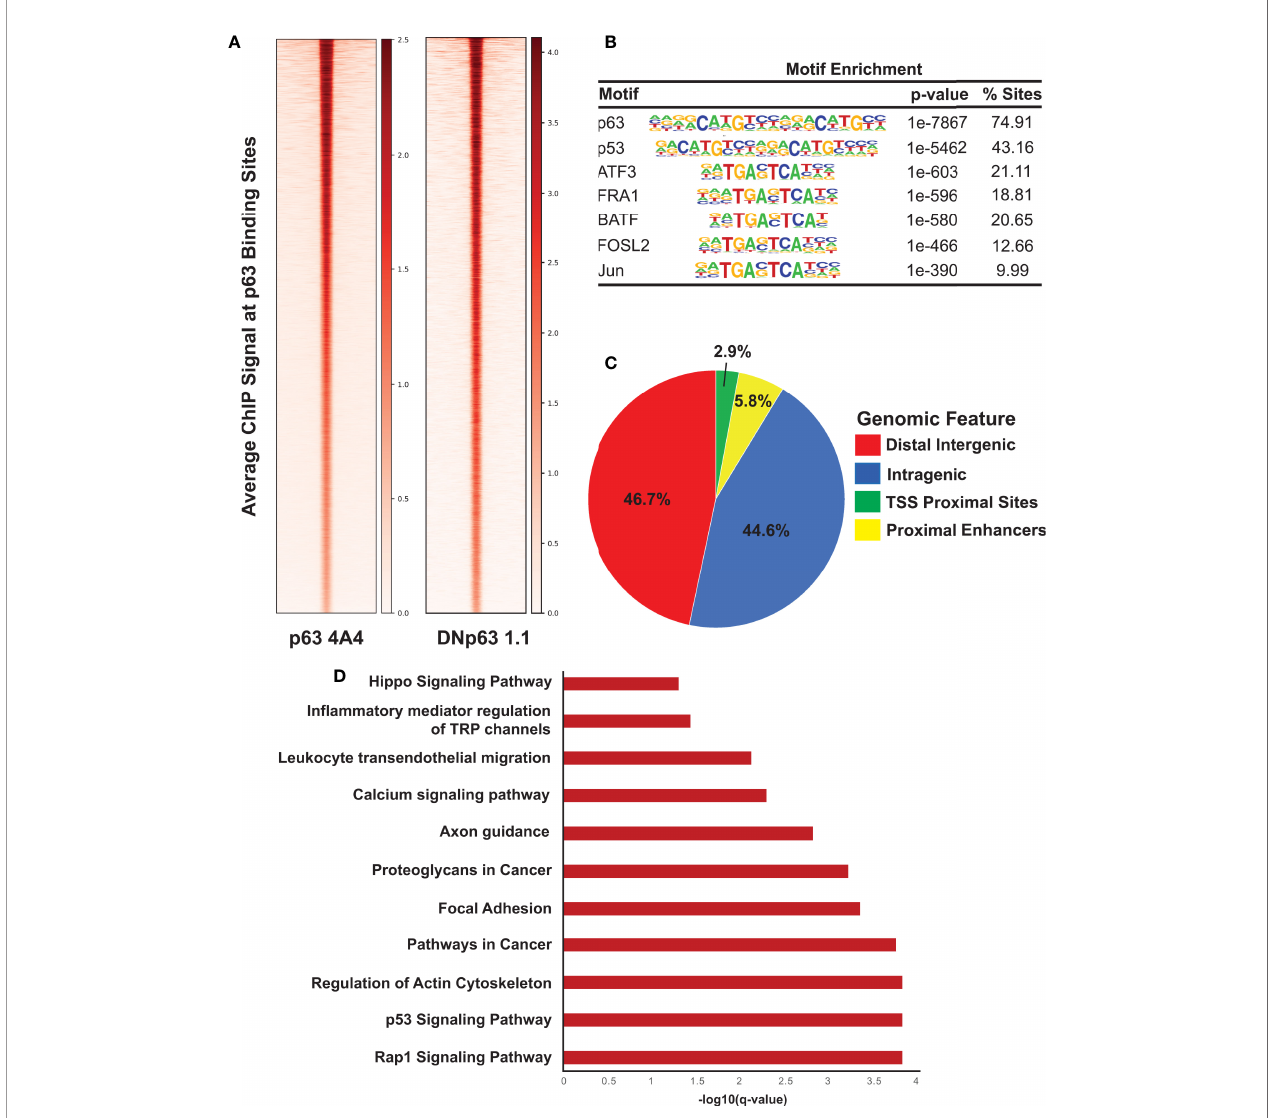
FIGURE 2 | ChIP-seq analysis reveals direct p63 targets in SCC104 cells. (A) Heatmap of the average ChIP-seq signals from p63 binding sites for two p63 antibodies across the genome. (B) Top transcription factor motifs derived from HOMER ’ s motif analysis on SCC104 consensus p63 ChIP peaks. (C) Distribution pattern of genomic features associated with p63 binding sites across the genome. (D) Bar graphs displaying selected top enriched KEGG pathways associated with genes identi fi ed through GREAT analysis of the top 2,500 p63 ChIP-seq